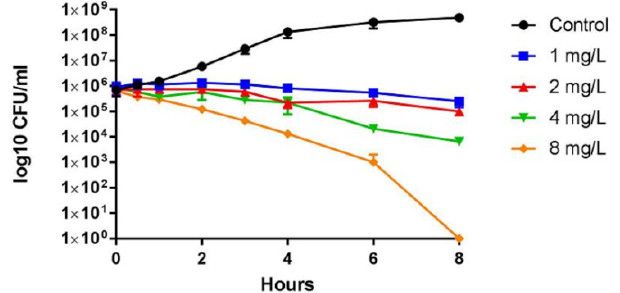
Figure 3. Growth and viability curves for S. aureus JE2. The figure shows growth and viability curves for S. aureus JE2 exposed to 0, 1, 2, 4, or 8 µg/mL of T5. The bacterial concentration (colony forming units (CFU)/ml) is shown on the log-transformed y -axis, and was determined at seven different timepoints during an eight-hour period. The experiment was repeated three times, and variations in the mean numbers of CFU/ml is indicated by the error bars.